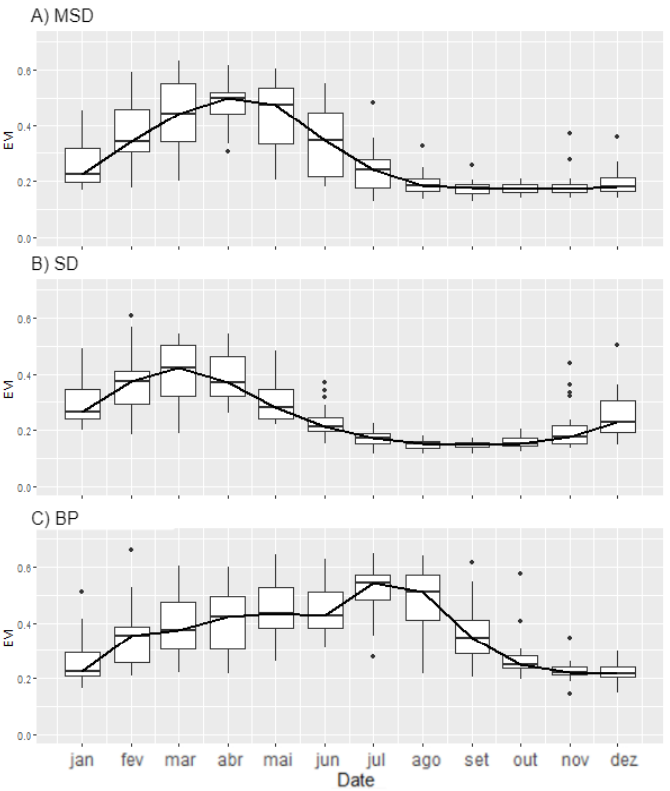
Figure 2. Monthly EVI values for 20 years of time series in ( A ) MSD ecoregion experimental, ( B ) SD ecoregion experimental, and ( C ) BP ecoregion experimental.